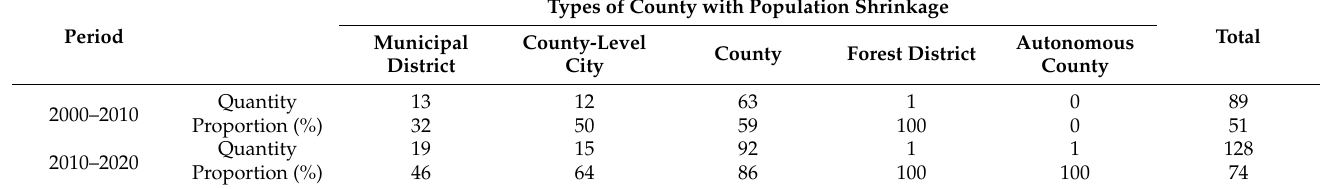
Table 2. The number of shrinking county units in the North–South Transitional Zone of China in different periods.